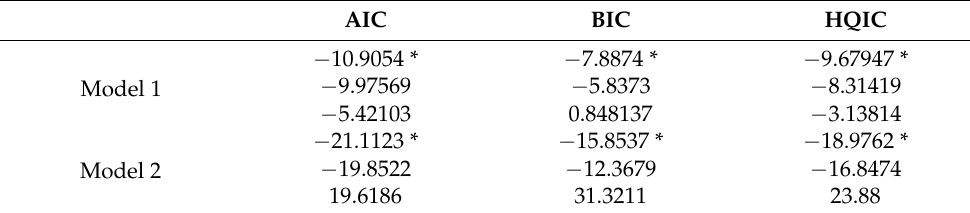
Table 6. Model lag order